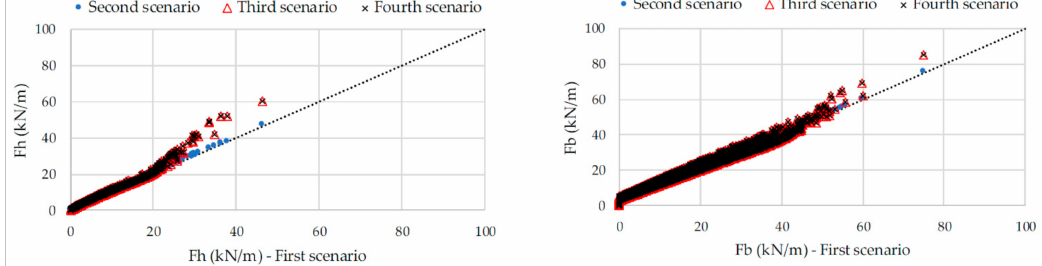
Figure 13. Horizontal and vertical forces for the first scenario compared with the second to fourth